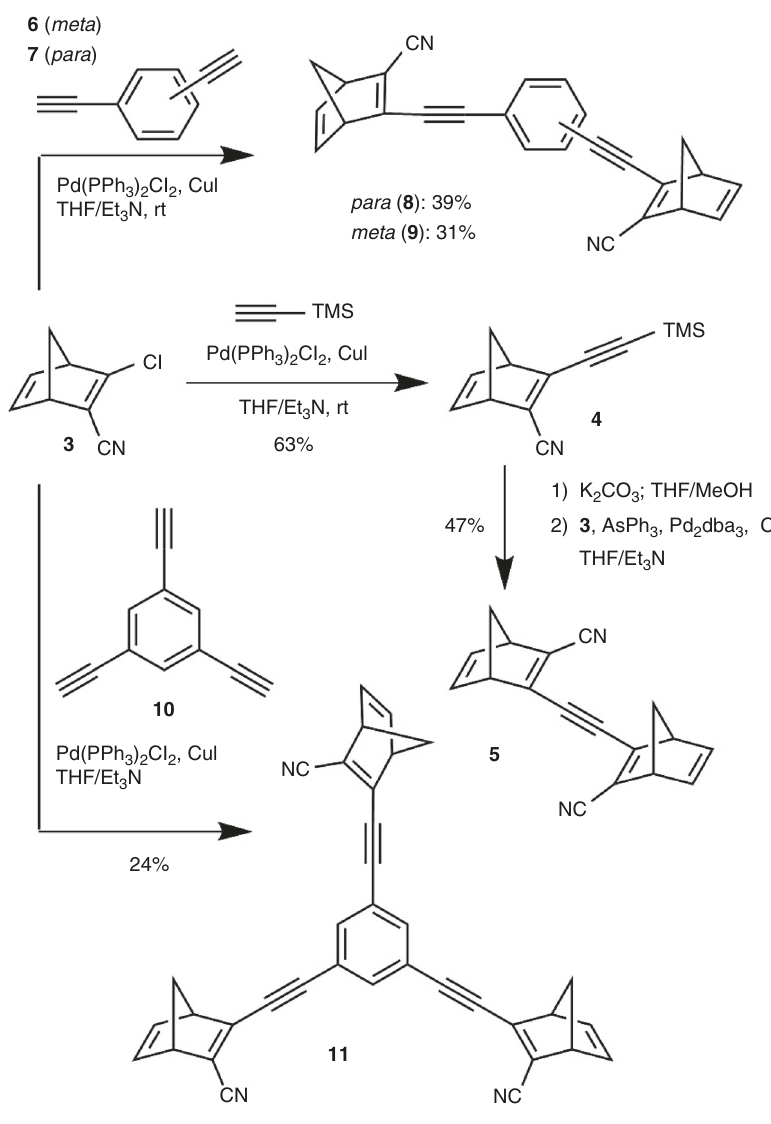
Fig. 3 Synthesis of alkyne-linked oligomers. Synthesis of acetylene-linked dimers 5 , 8 , and 9 as well as the trimer 11